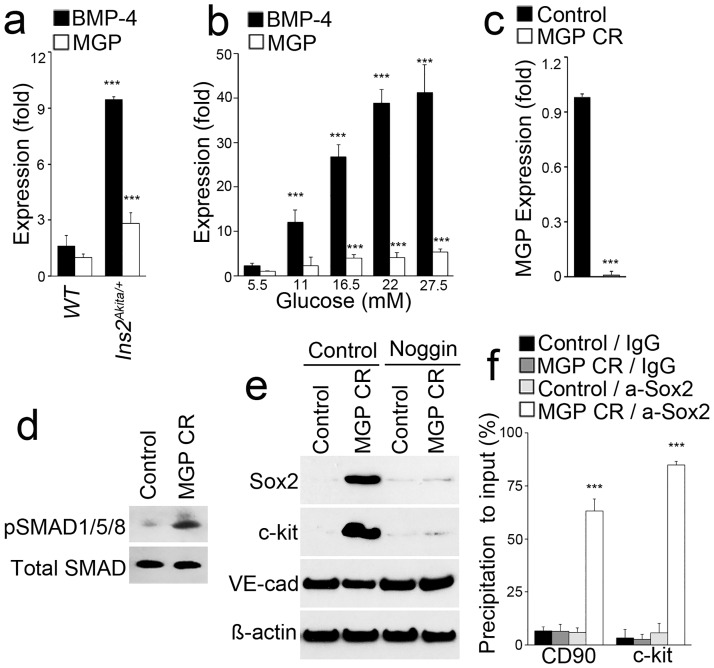
Sox2 activates CD90 and c-kit in MGP-deficient HAECs.(a-b) Expression of BMP-4 and MGP in endothelium of Ins2Akita/+ mice (a) and in HAEC (b) treated with different concentrations of glucose. (c-d) MGP expression and pSMAD1/5/8 level in HAECs after depletion of MGP by using CRISPR/Cas9 (MGP CR). (e) Expression of Sox2, c-kit and VE-cadherin (VE-cad) in MGP-depleted HAECs (MGP CR) with or without Noggin treatment. (f) ChIP assay shows abundant Sox2-binding in the promoters of CD90 and c-kit in MGP-depleted HAECs (MGP CR). a-Sox2: anti-Sox2 antibodies. ***, p<0.0001.